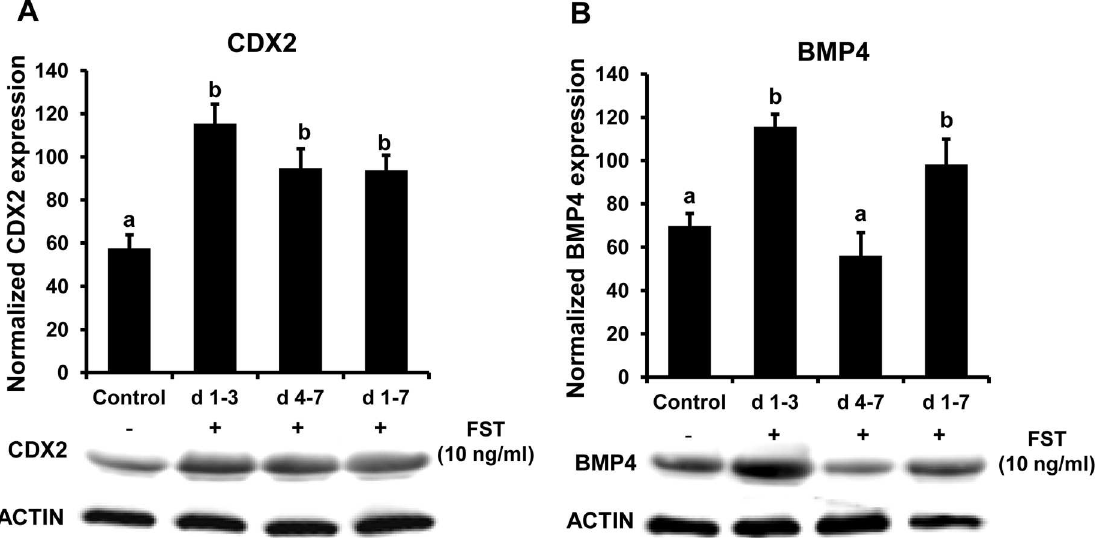
Fig 5. Stage-specific effects of follistatin treatmenton protein abundance of TE cell lineage markers(CDX2 and BMP4) in bovine d7 blastocysts. Effect of exogenousfollistatinsupplementation duringpre-compaction (d 1–3), peri-/post-compaction (d 4–7) and entireperiod(d 1–7) of in vitro embryo cultureon (A) CDX2 and (B) BMP4 proteinabundanceas determined by Western blot analysisin bovineblastocysts collectedon d 7 after insemination. Values are shownas the mean ± SEM of the data collectedfrom 4 replicates (n = 10 blastocyst/treatment in each replicate).Values accompanied with differentletters across the treatments indicatesignificantdifference ( P <